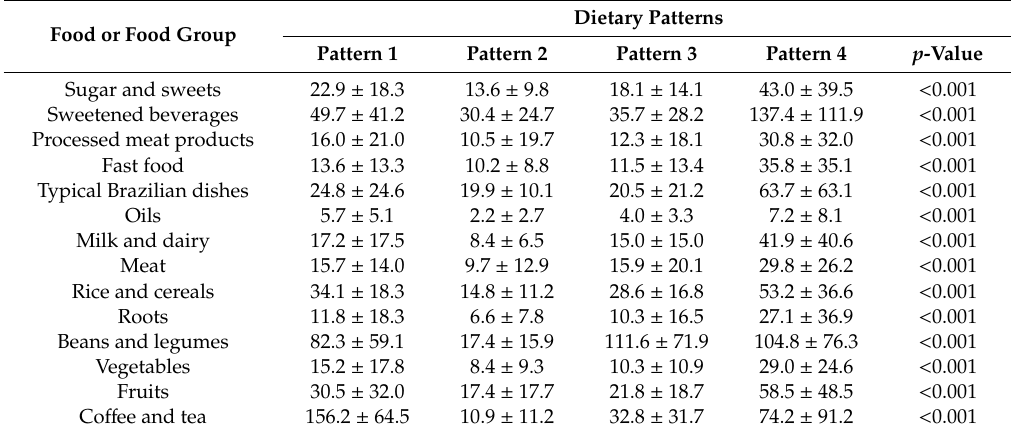
Table 3. Abundance of consumption of each food group in the diet in di ff erent dietary patterns.